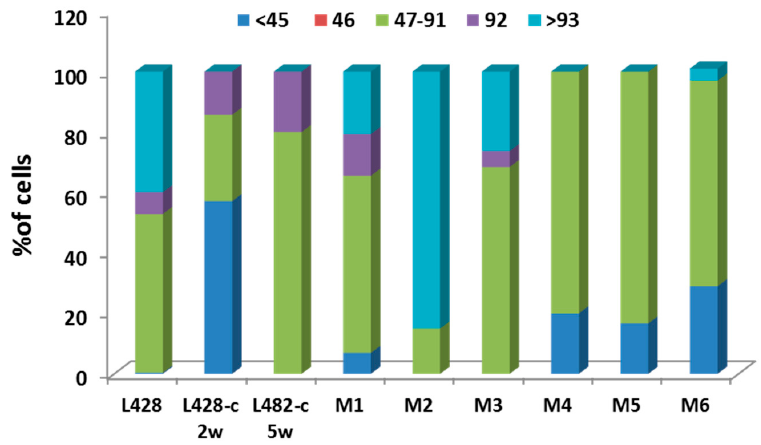
Figure 5. Numerical chromosomal aberrations were scored after telomere and centromere staining of the L428 parental cell line, the L428-c subline after two and five weeks in culture, and in HL cells derived from the livers of six mice (M1–M6) 16 and 32 weeks after injection, respectively.